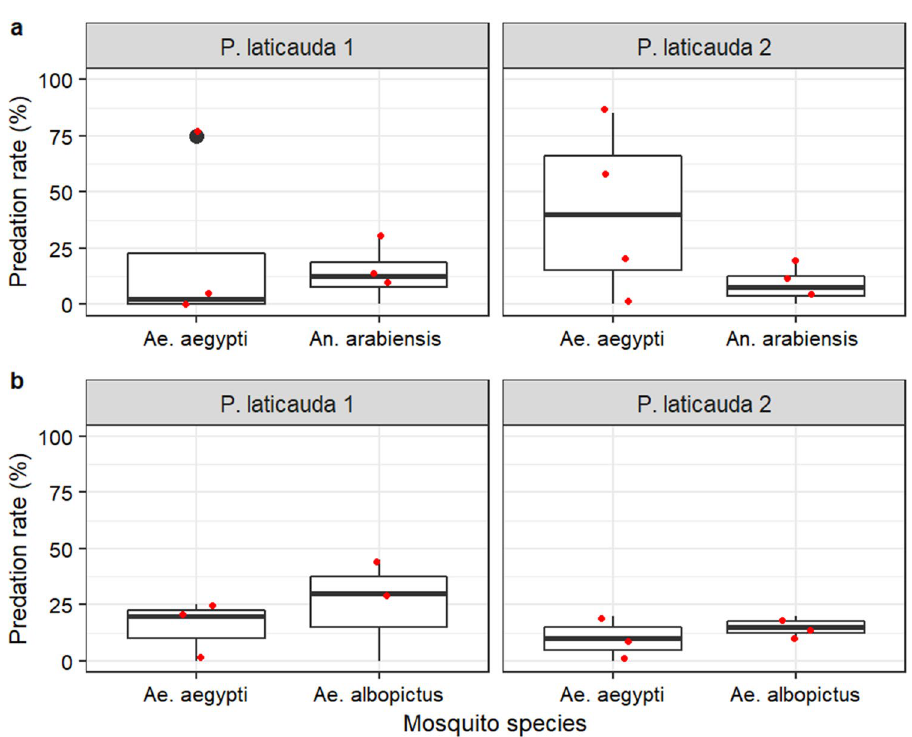
Figure 7. Effect of mosquito species on Phelsuma laticauda predation. ( a ) Aedes aegypti versus Anopheles arabiensis; ( b ) Aedes aegypti versus Aedes albopictus